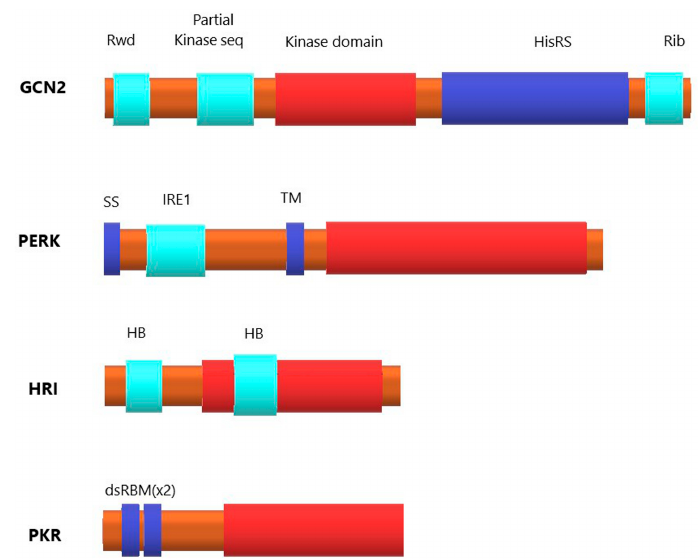
Figure 1. Domain structure of four kinases targeting α -subunit of eukaryotic initiation factor 2. The catalytic domain (red) is present in all four kinases. General control nonderepressible 2 ( GCN2 ): the RWD sequence (domain in RING finger and WD repeat containing proteins and DEXDc-like helicases) associates with the activator protein GCN1 (general control of amino-acid synthesis 1-like protein 1), partial kinase domain is a cis-regulatory element, the HisRS (histidyl-tRNA synthetase)-related sequence binds with uncharged tRNA, and the C-terminal region facilitates GCN2 dimerization and its ribosome association. PKR-like endoplasmic reticulum kinase ( PERK ): the signal sequence (SS) facilitates translocation of N-part of kinase into the lumen of endoplasmic reticulum, the IRE1 (inositol-requiring enzyme 1)-related sequence is the unfolded protein response sensor, TM is the transmembrane segment. Heme-regulated eIF2 α kinase ( HRI ): the molecule contains two heme-binding regions, one of which is inserted into the catalytic domain. Protein kinase R ( PKR ): two dsRBM motifs interact with double-stranded